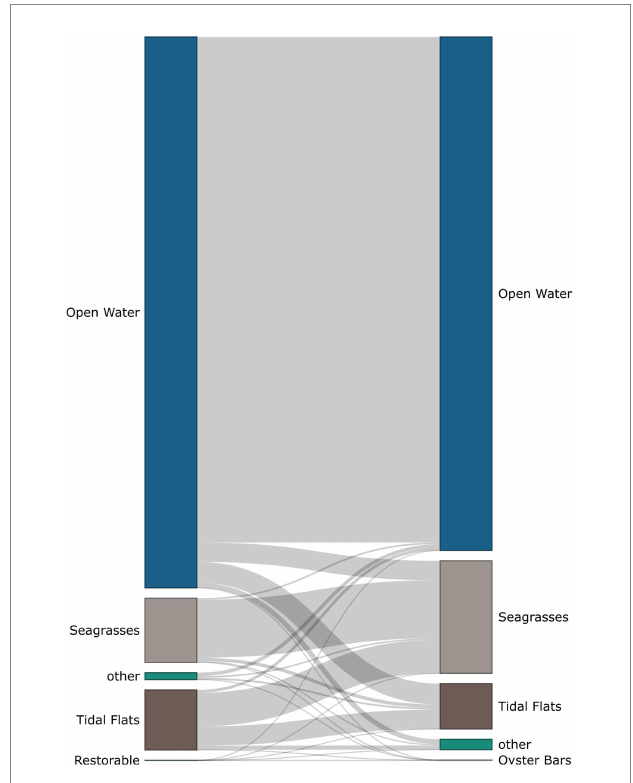
FIGURE 3 Change analysis of habitat categories in the subtidal strata of the Tampa Bay watershed. The left column shows relative areas in 1988 and the right column shows relative areas in 2018 for each habitat category, where the bar heights are proportional to extents in each year. The grey lines show the proportional change in area of each habitat category between the